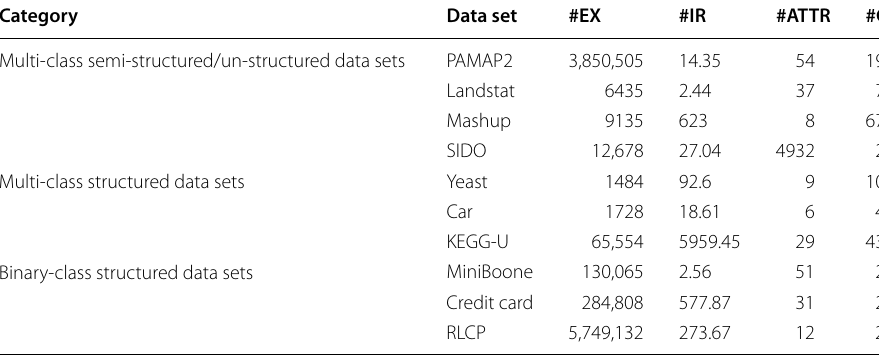
Table 1 Features of data set